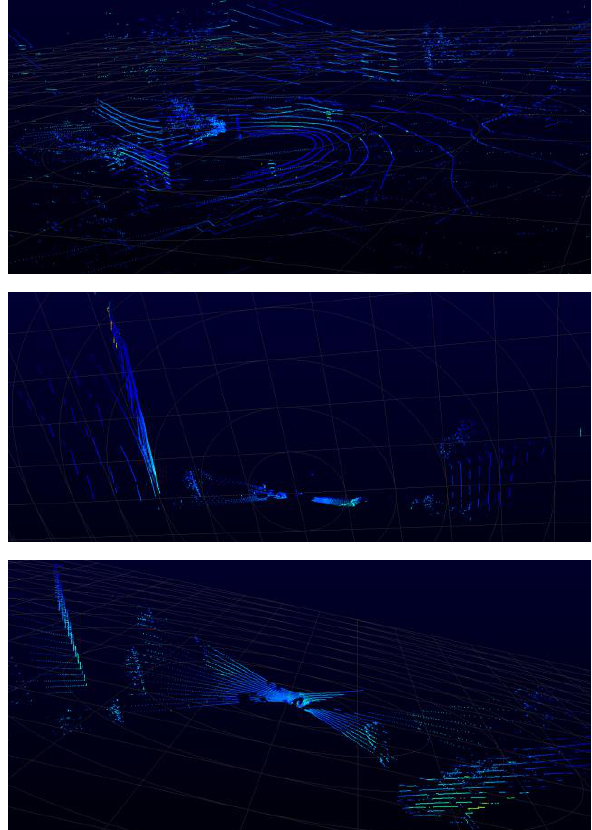
Figure 5. Point cloud captured in outdoor environment (single frames from VeloView): horizontal scanner VELO_1 (top), vertical scanner VELO_3 (middle), 45º scanner VELO_2 (bottom).